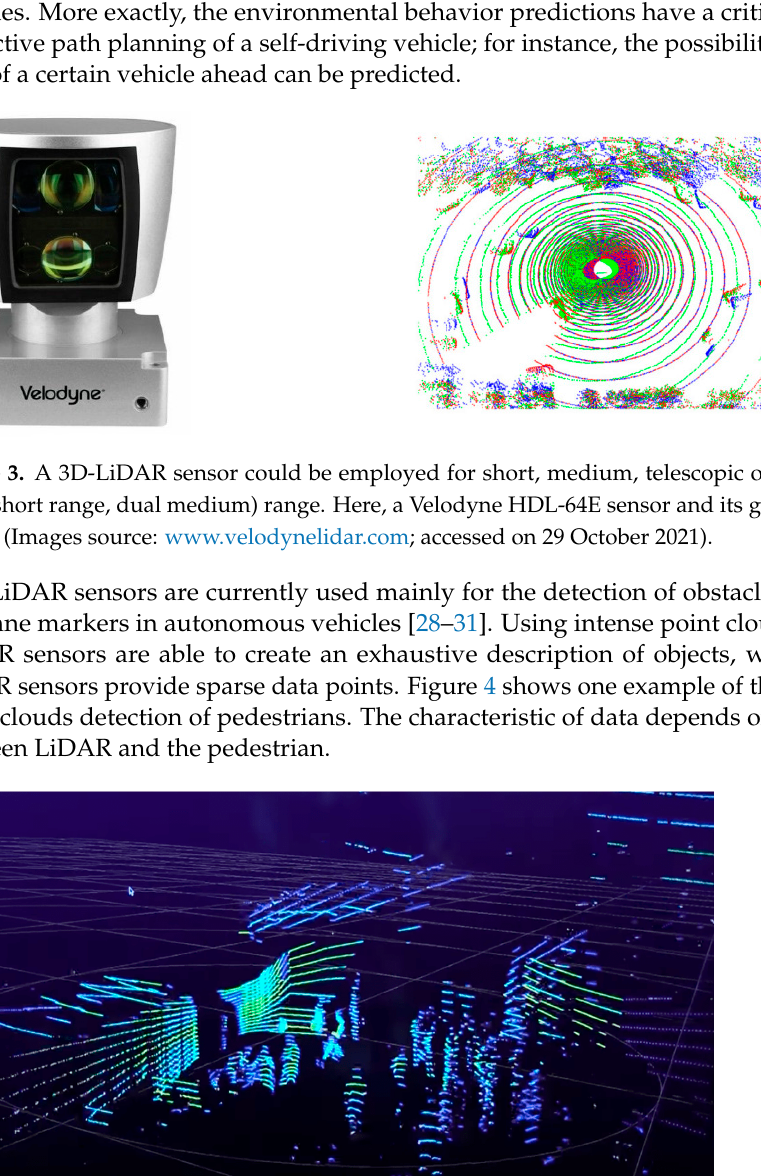
Figure 4. Raw LiDAR data of pedestrians, captured using Velodyne HDL sensor. (Images source: www.velodynelidar.com; accessed on 29 October 2021).